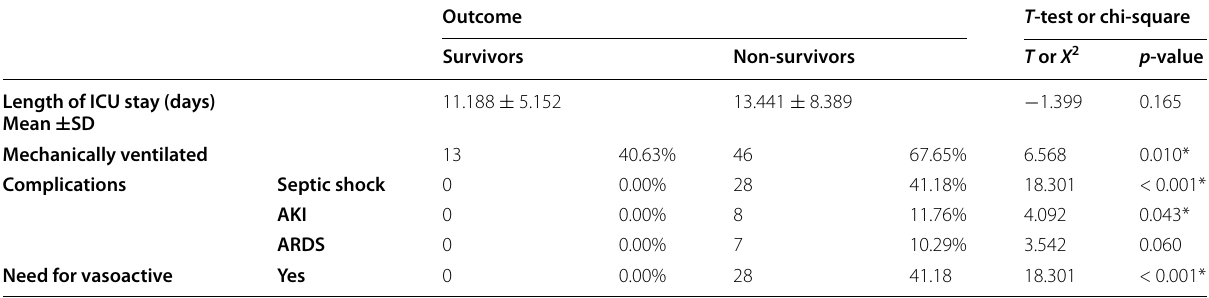
Table 4 Comparison between survivors and non–survivors from sepsis as regards